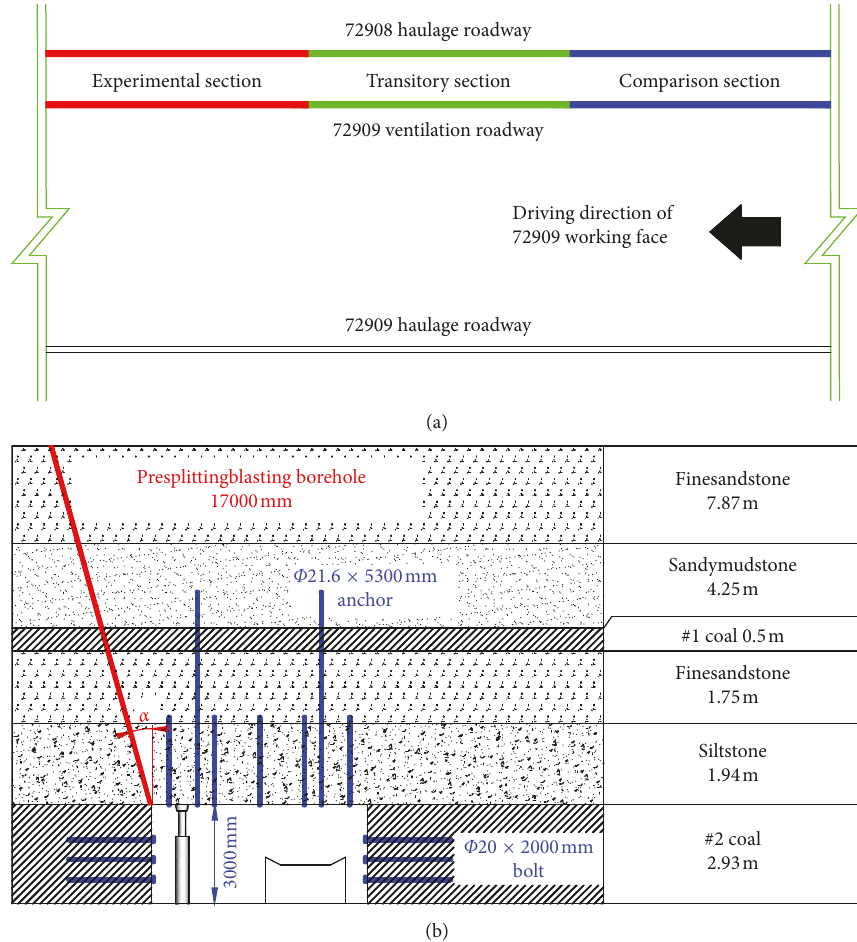
Figure 12: (a) Partition of test section and (b) presplitting blasting in the 72908 haulage roadway.